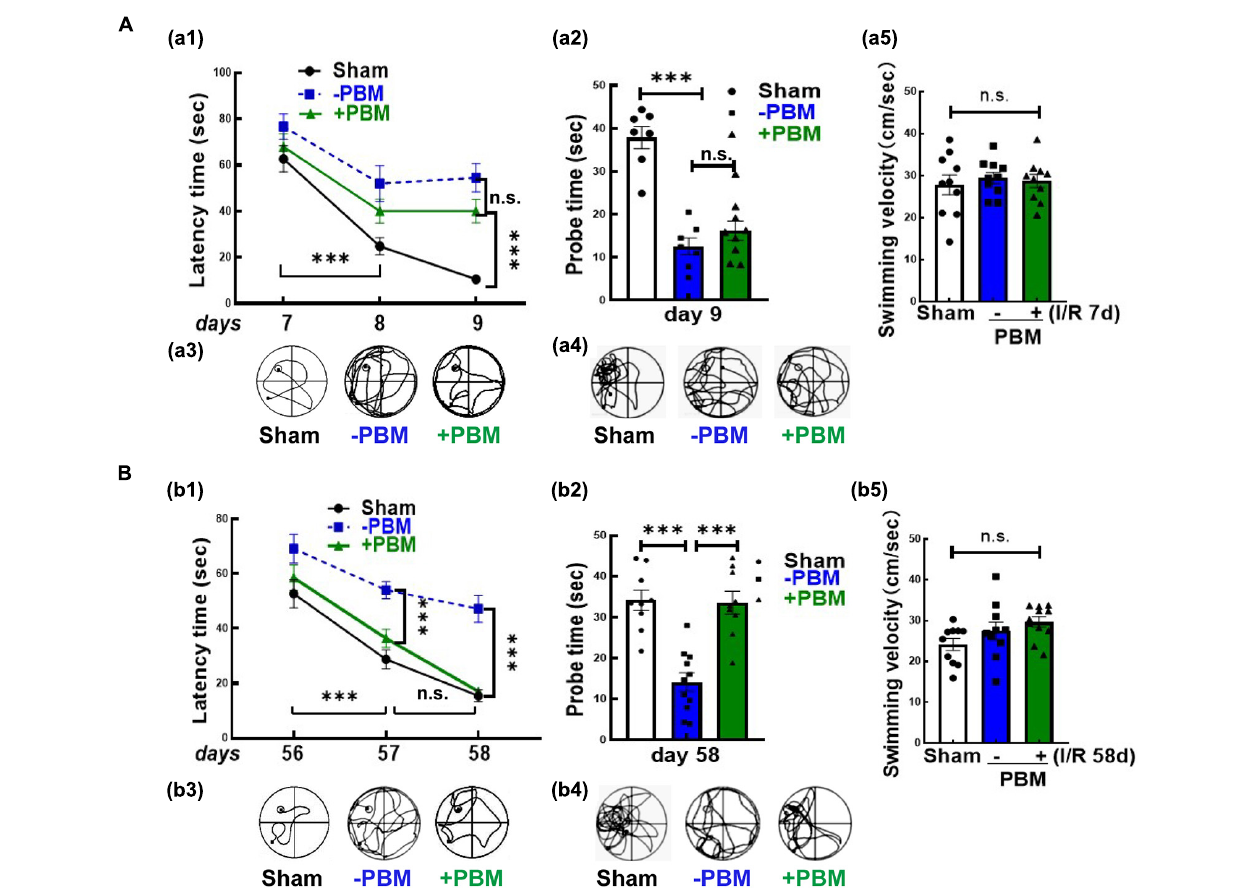
FIGURE 2 | Photobiomodulation treatment only improves functional outcome at the later time point (56–58 days) but not at the early time point (7–9 days) after GCI. Spatial learning/memory test in the Morris water maze 7–9 days (A) and 56–58 days (B) after GCI. (a1,b1) Latency trial and (a2,b2) probe trial; swimming paths of the rats from latency trials and probe trials on day 9 (a3,a4) and day 58 (b3,b4) ; swimming velocity of probe trials on day 9 (a5) and day 58 (b5) after GCI ( n = 10–11 in each group). ∗∗∗ P < 0.001 between the two groups. n.s., no significant difference. GCI, global cerebral ischemia; PBM,